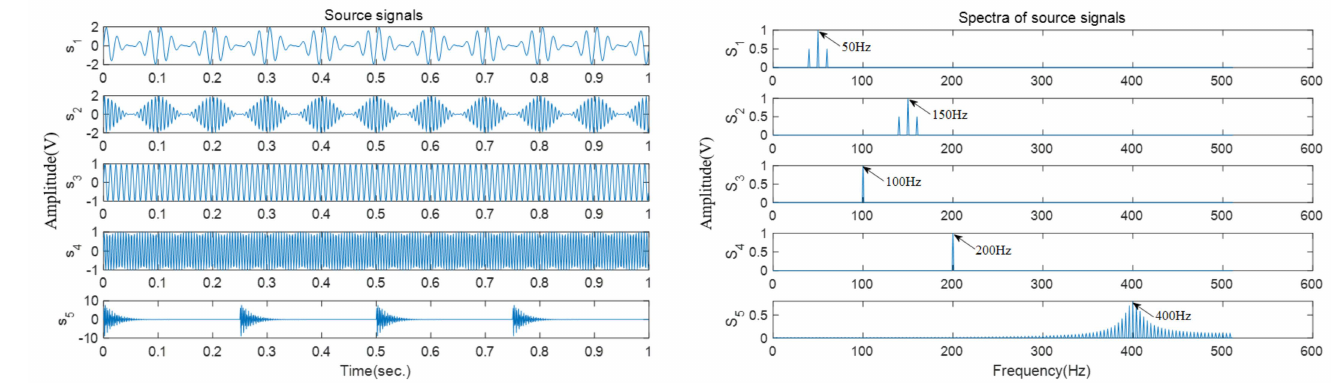
Figure 4. Time − domain waveforms and frequency spectra of the simulated